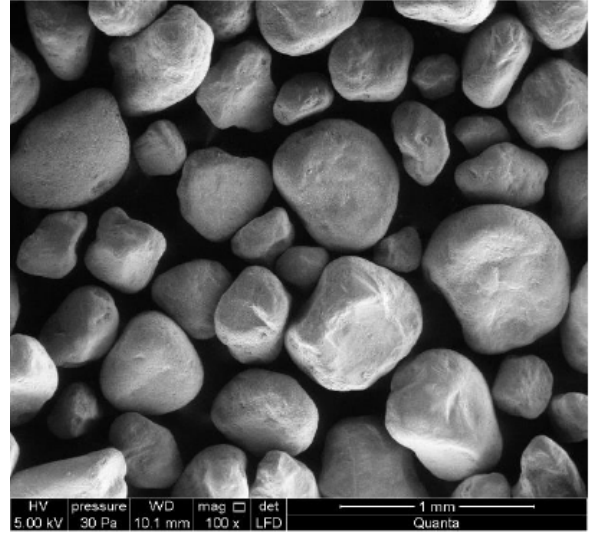
Figure 17: Microstructure of